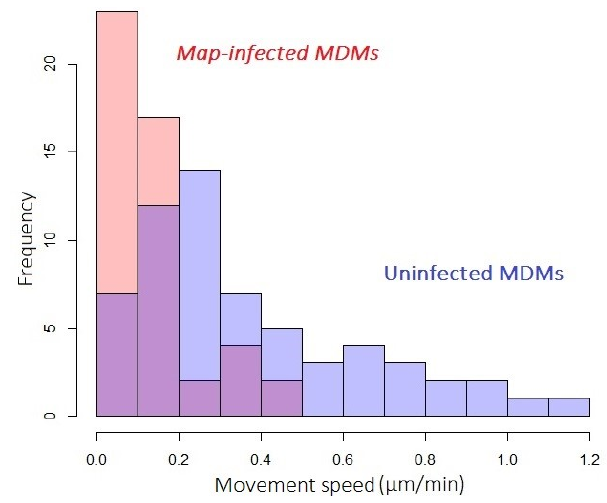
Figure 6. Map -infected MDMs show decreased movement speed. Histograms describing the motility of populations of Map -infected (red) and uninfected (blue) MDMs exposed to Map at MOI of 1:4. Overlap of histograms in purple.